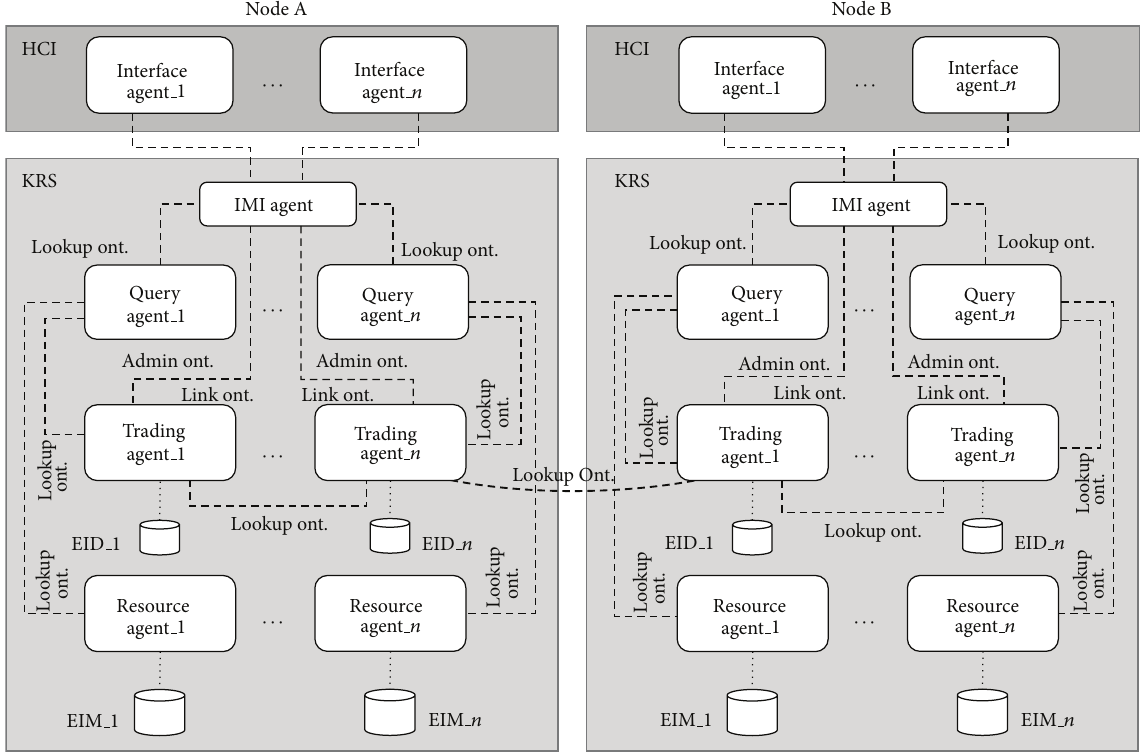
Figure 9: The general OntoTrader -based